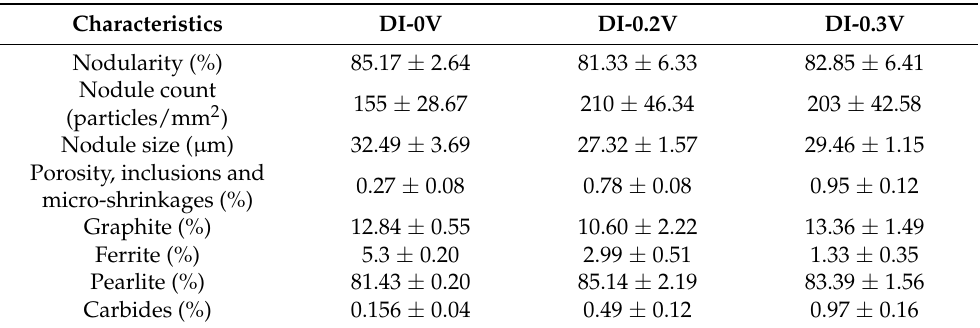
Table 2. Graphite features and volume fraction of phases formed for camshafts unalloyed and alloyed with 0.2 and 0.3%